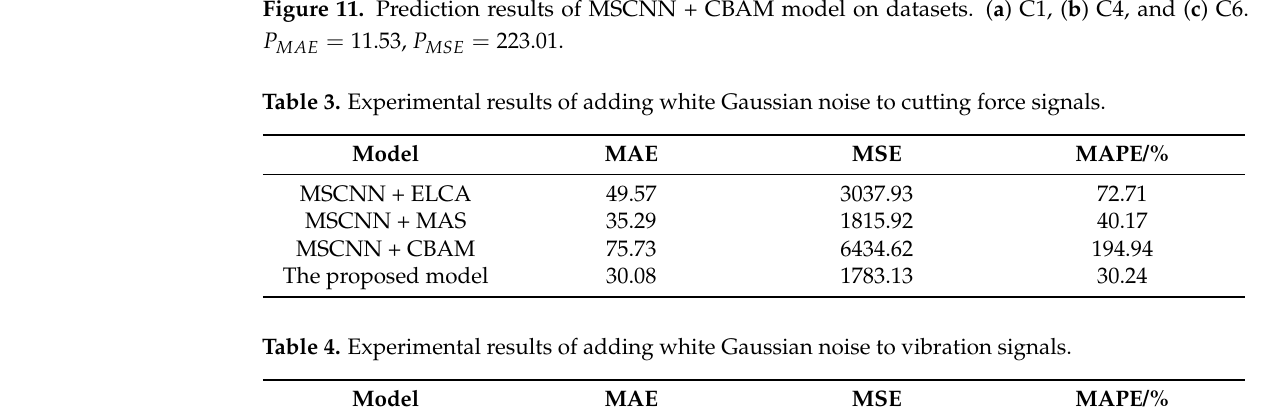
Table 3. Experimental results of adding white Gaussian noise to cutting force signals.